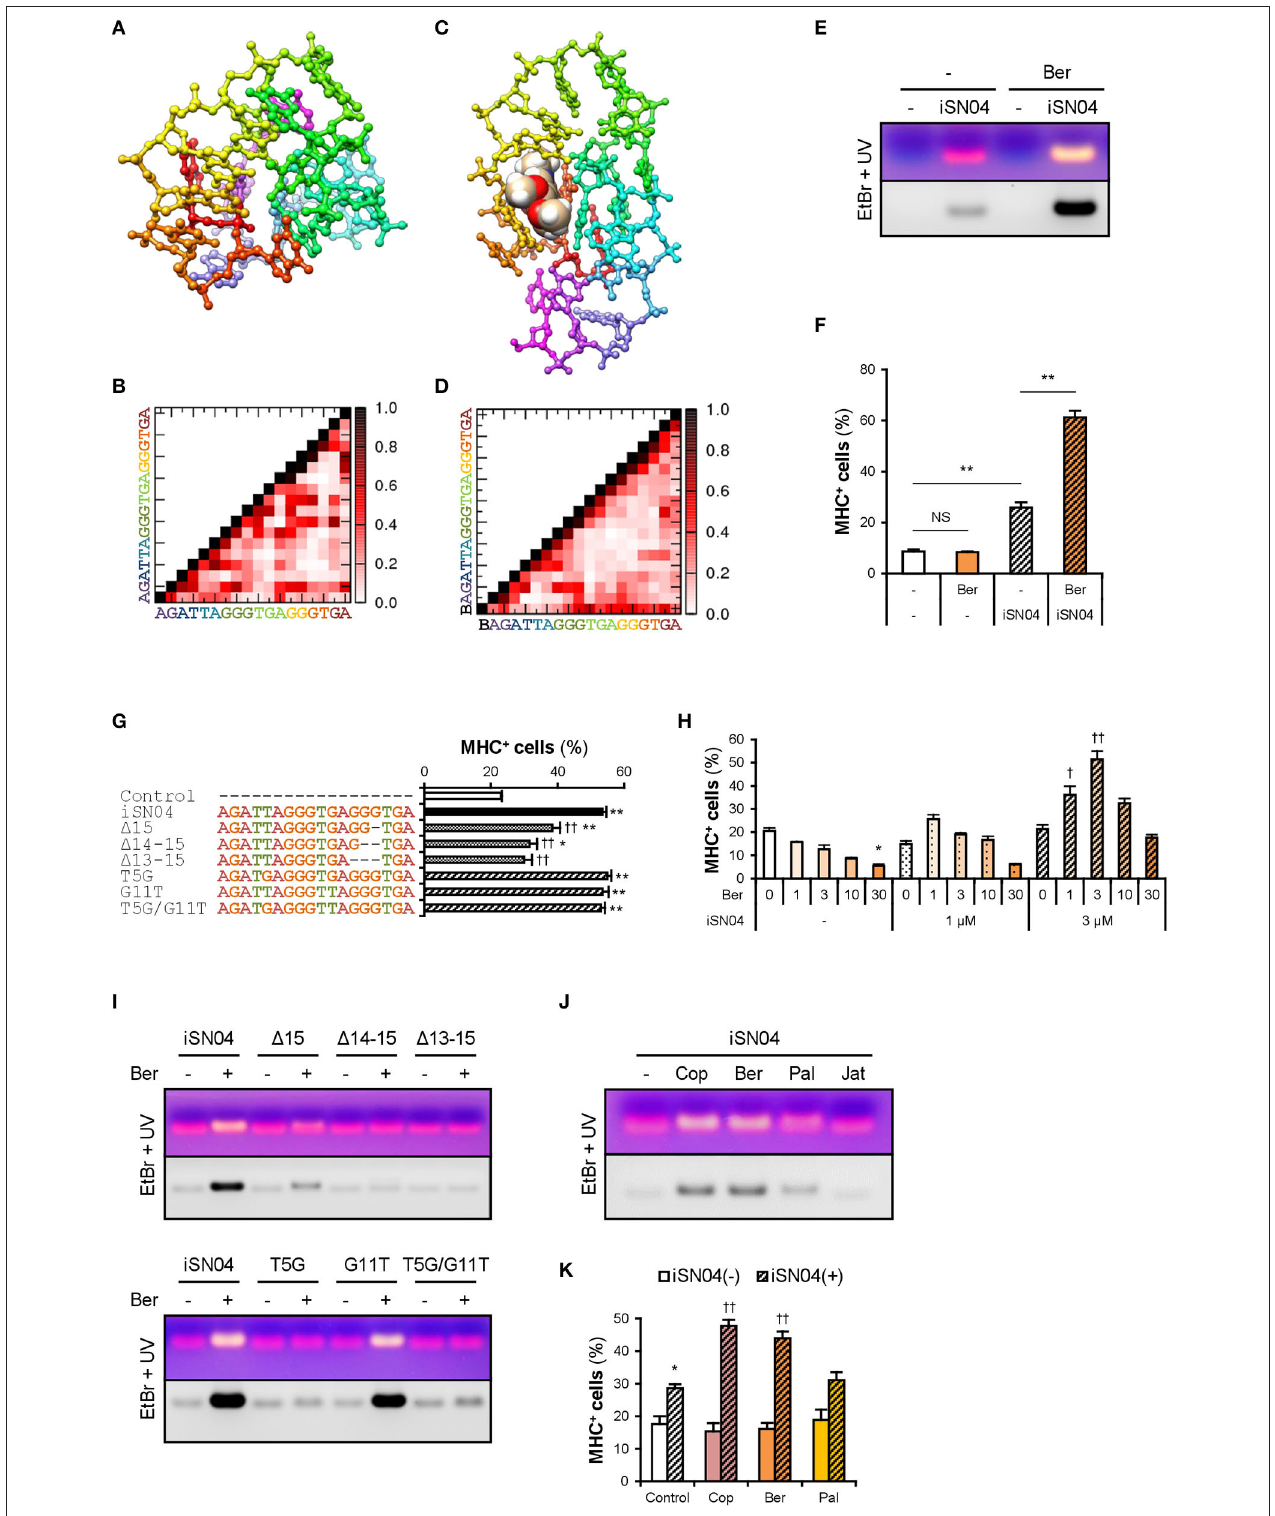
FIGURE 3 | Berberine enhances iSN04 activity by causing a shift in molecular structure. (A) The conformation of iSN04 simulated via TTP-McMD. (B) Contact map of iSN04. The scale indicates contact probability. (C) The simulated conformation of iSN04-berberine complex. Berberine is shown as a sphere model. (D) Contact map